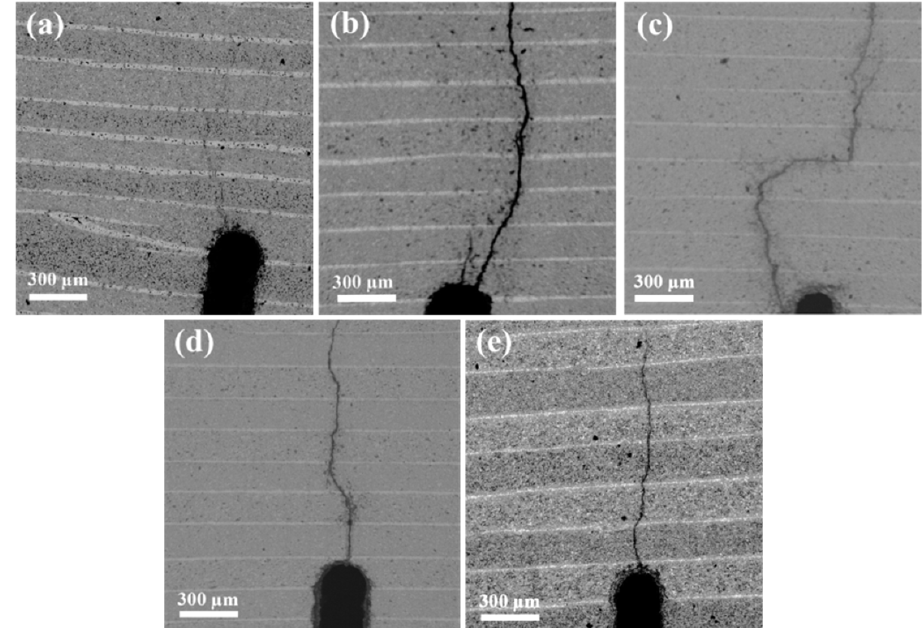
Figure 6. SEM images of the crack propagation paths in the laminated ceramics with different layer thickness ratios: ( a ) λ = 7, ( b ) λ = 10, ( c ) λ = 13, ( d ) λ = 16, ( e ) λ = 19. According to the crack propagation paths in the laminated ceramics shown in Figure 6, it could be found that the laminated ceramic with a layer thickness ratio of 13 had the best performance. Figure 7 show SEM images of the overall cross-section (a),the selected area including the matrix layer and the interlayer (b) and higher magnification of the selected area (c) of the laminated ceramic with the layer thickness ratio of 13. The laminated structure was observed in Figure 7a. As shown in Figure 7b, there were the ZM30 layer, the interlayer, and the ZM20 layer from top to bottom in the enlarged view of the laminated structure. According to the higher magnification image shown in Figure 7c, the fracture mode of the laminated ceramic was a mixture of transgranular fracture and intergranular fracture. Moreover, the matrix layer and the interlayer were tightly bonded because of the reaction of Mo and ZrB 2 at the